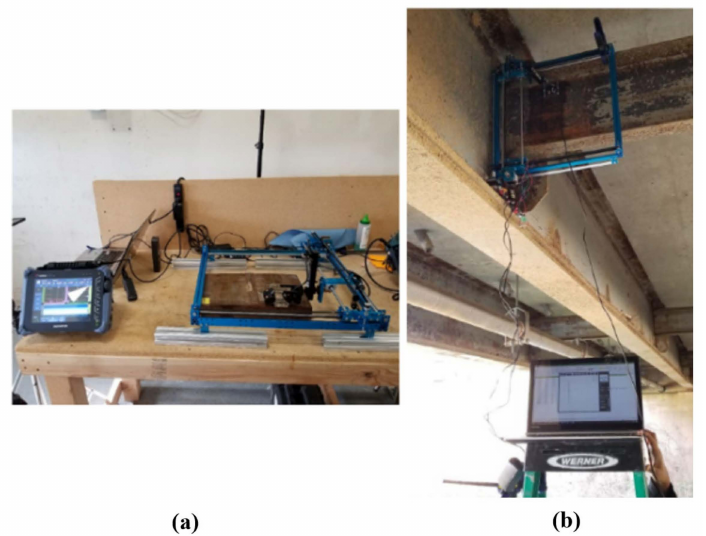
Figure 37. Testing of the prototype AUT system in the lab on steel plate ( a ) and on the in-service bridge ( b )